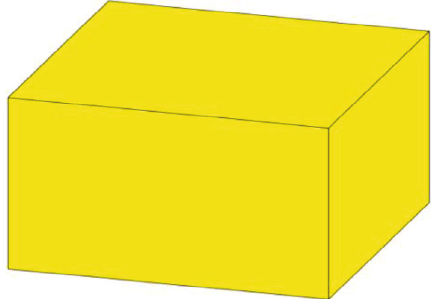
Figure 2: Arbitrary discrete element in a three-dimensional